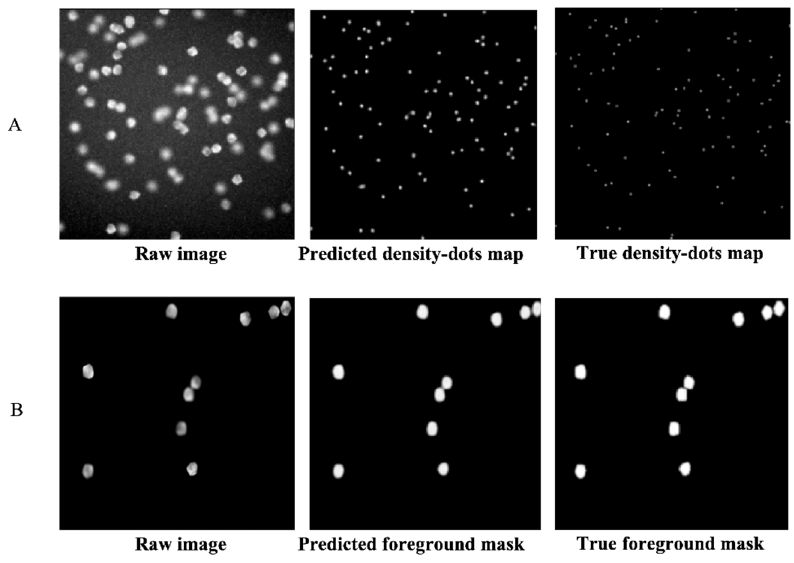
Figure 2. Features predicted by autoencoders of DRDCNN and FRDCNN. ( A ): Predicted dot density